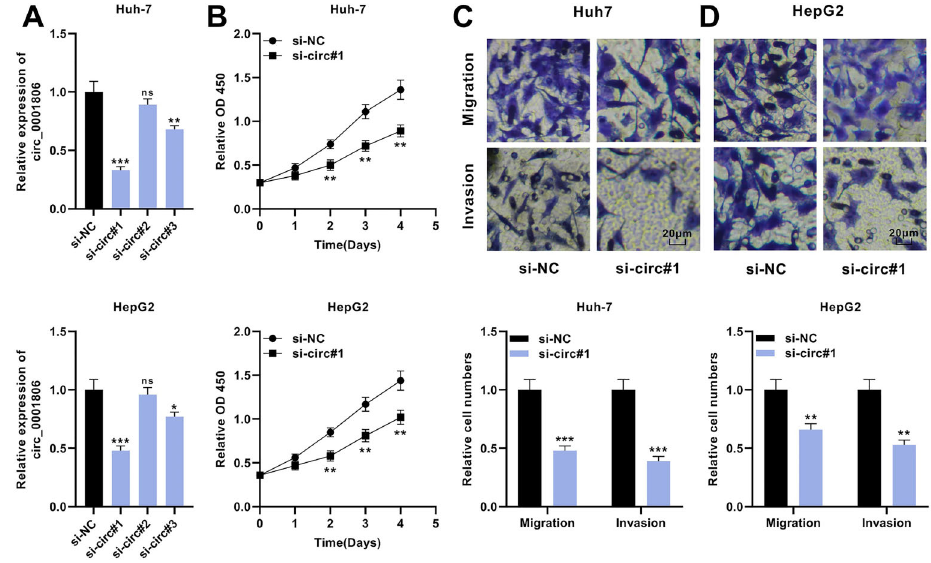
Figure 2. Knockdown of circ_0001806 inhibits multiplication, migration, and invasion of HCC cells. A , Three siRNAs targeting circ_0001806 (si-circ_0001806#1, si-circ_0001806#2, and si-circ_0001806#3) were transfected into Huh-7 and HepG2 cells and the expression level of circ_0001806 was detected by qRT-PCR. B , CCK-8 method was used to detect the multiplication of Huh-7 and HepG2 cells after transfection. C and D , Transwell experiment was employed to detect the migration and invasion of Huh-7 and HepG2 cells after transfection (scale bar 20 m m). Data are reported as means ± SD. *P o 0.05, **P o 0.01, ***P o 0.001; ns, not statistically signi fi cant (ANOVA and t